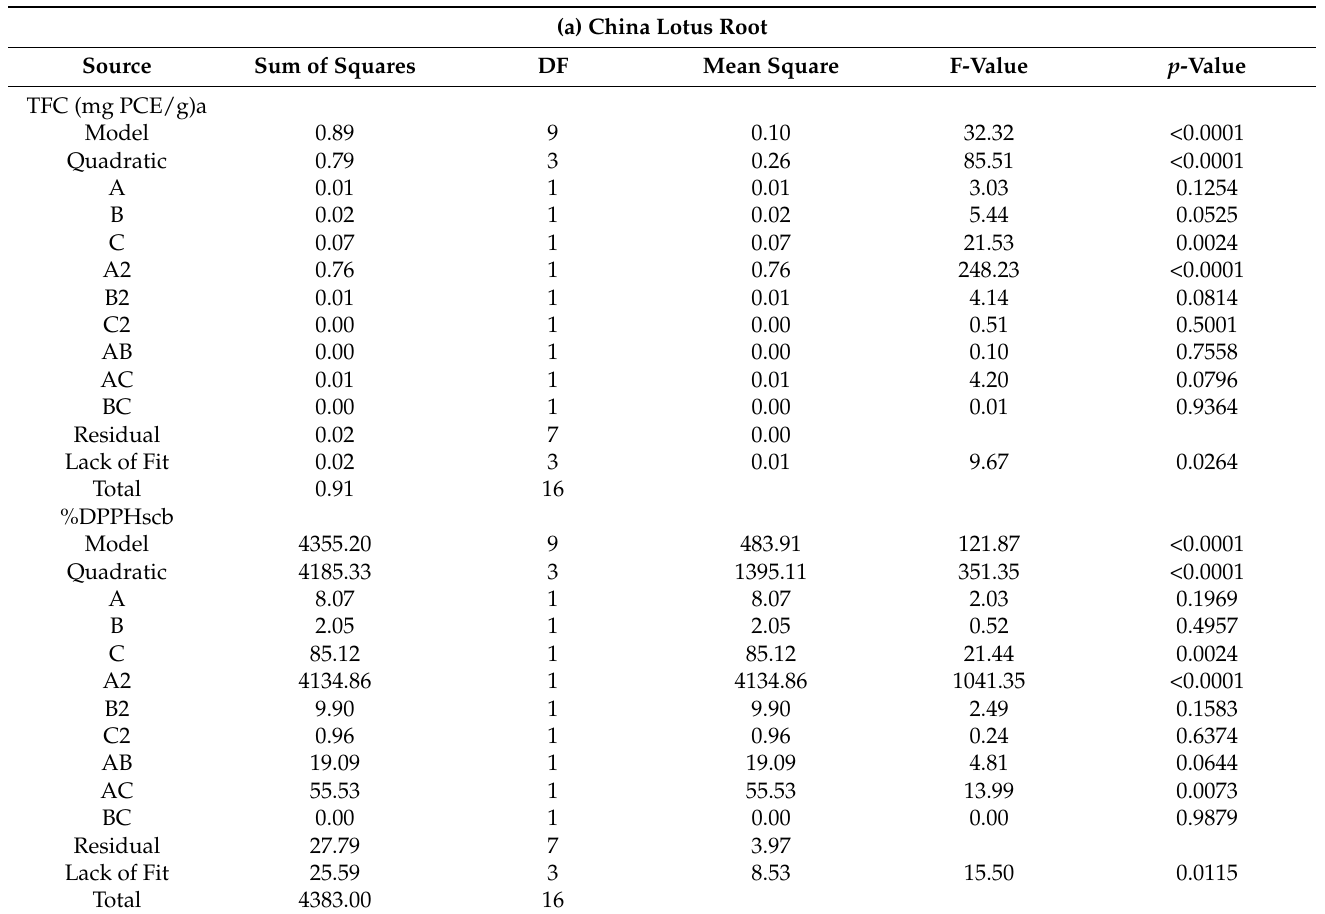
Table 1. ANOVA for response surface models: estimated regression model of relationship between response variables (TFC, %DPPH sc and FRAP) and independent variables (X 1 ,X 2 ,X 3 ) from (a) China lotus root and (b) Malaysia lotus